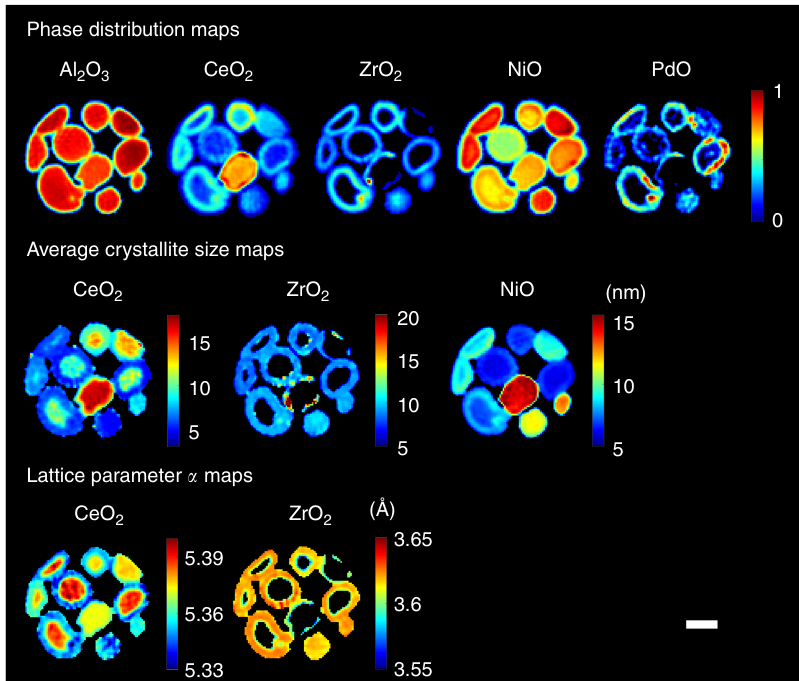
Fig. 1 Maps derived from the Rietveld analysis of the XRD-CT data collected at the middle of the fresh catalyst bed. Top: phase distribution maps of Al 2 O 3 , CeO 2 , ZrO 2 , NiO and PdO corresponding to the normalised scale factors of these phases. Middle: average crystallite size maps of CeO 2 , ZrO 2 and NiO (colorbar axes in nm). Bottom: Maps corresponding to the lattice parameter a of CeO 2 and ZrO 2 unit cells (colorbar axes in Å). Scale bar corresponds to 0.5